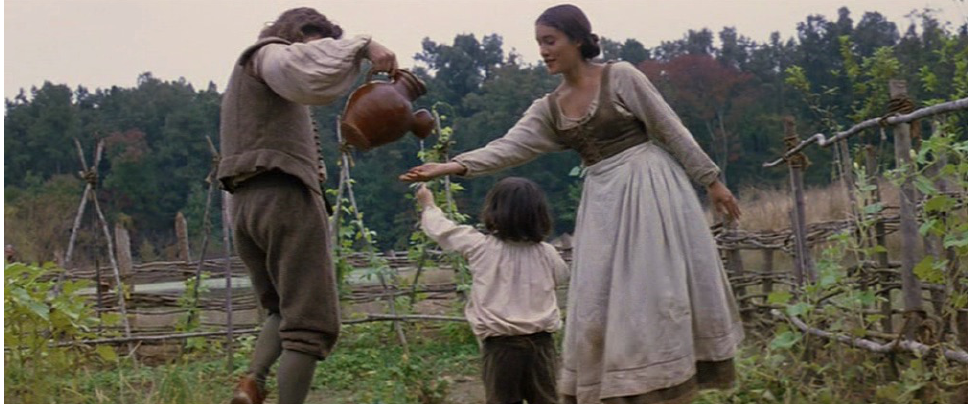
Figure 7: The jug ‘things’ in the hands, and play, of Pocahontas, Rolfe and their